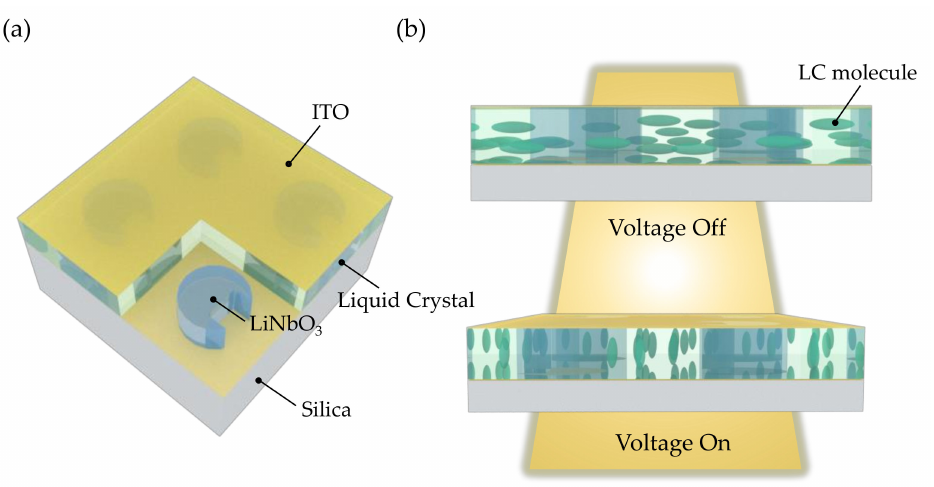
Figure 7. ( a ) Sketch of the LiNbO 3 metasurface immersed in LCs. ( b ) Schematic view of the LC alignment for no applied voltage and for the case when a voltage of 70 V is applied between the two